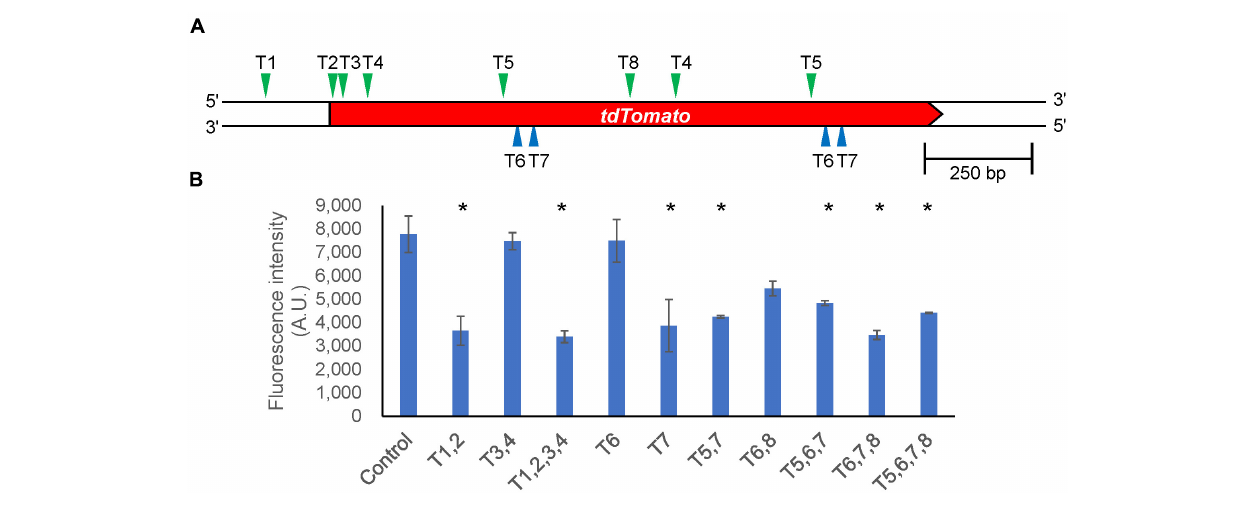
FIGURE 7 | Silencing gene expression by CRISPRi. (A) Schematic illustration of target sites in the tdTomato knock-in region. The position of each target site on the upper strand and complementary lower strand is indicated by green and blue arrowheads, respectively. (B) Intracellular fluorescence intensity in different target combinations. Data shown are mean ± SEM ( n = 3 biological replication). * P < 0.05; ANOVA folloed by Tukey’s post hoc